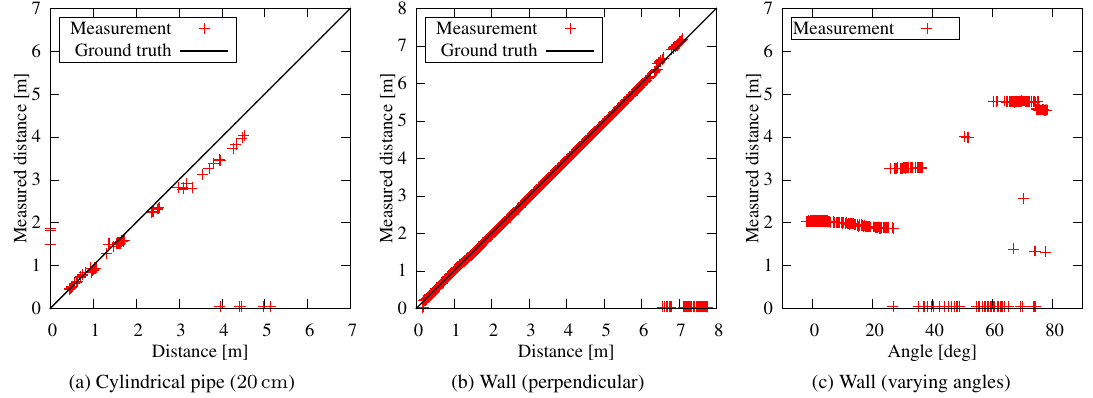
Figure 9: Experimental evaluation of ultrasonic range readings in different situations: varying distances to a cylindrical pipe (left) and to a perpendicular wall (middle) with ground truth (black line), and distances to a wall with varying measurement angle. Filter (EKF). Our implementation is based on the Bayesian Filter-